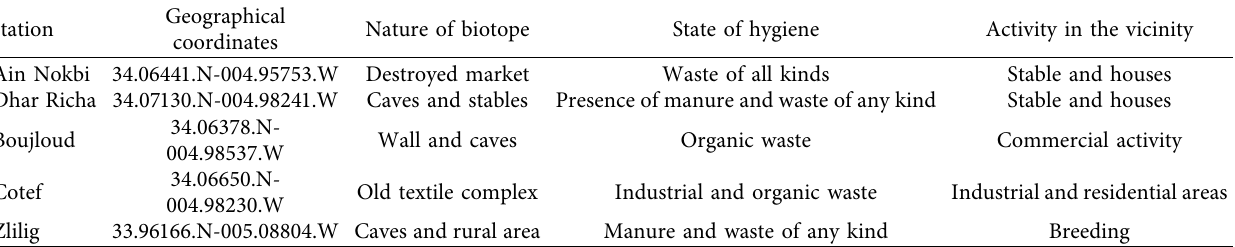
Table 1: Environmental conditions of the five-trapping